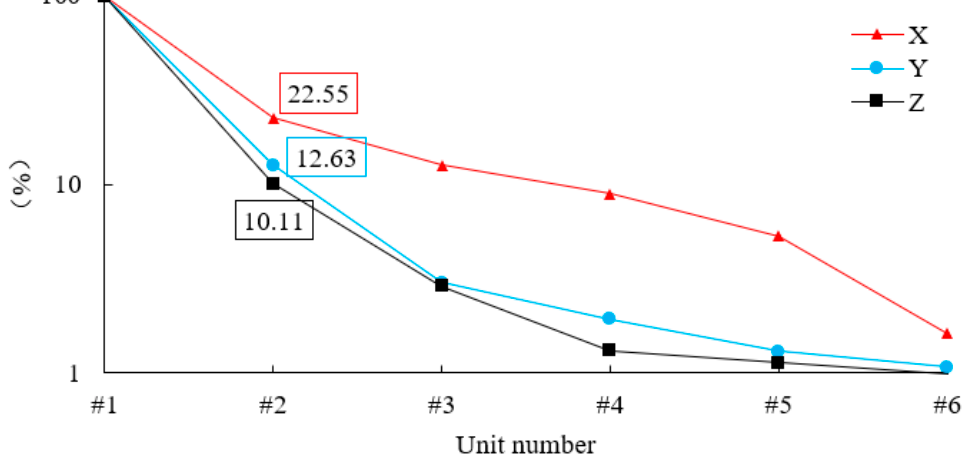
Figure 20. Transmission ratios of vibration in three directions. Table 2. Ratios of vibration displacements of different units in three directions